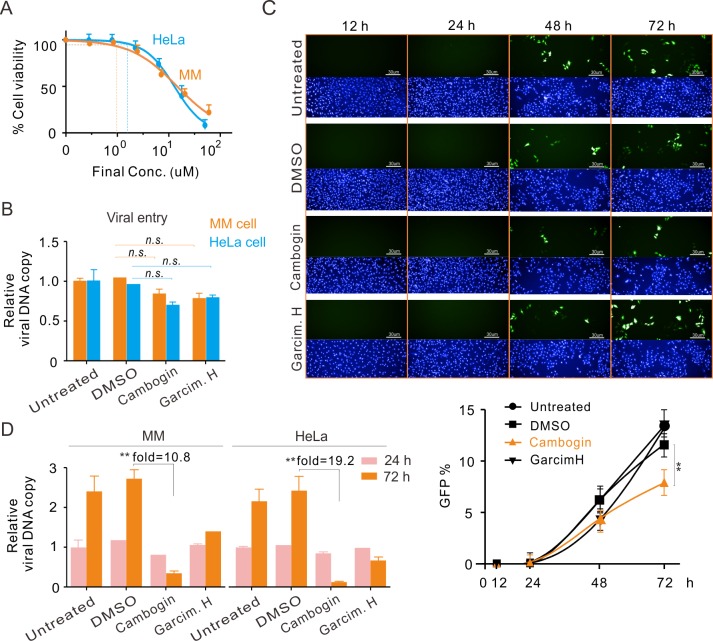
Cambogin inhibits KSHV de no infection in vitro.(A) The cell viability of HeLa and MM cell lines with different dosage of Cambogin treatment for 48 h. The concentration of Cambogin-induced 10% cell death (CC10) was indicated. (B) Cambogin does not impair viral entry. Equal amount of HeLa or MM cells incubated with GFP-tagged KSHV virions (MOI = 2) in the presence or absence of 100 nM Cambogin and Garcimultiflorone H (DMSO as a control), were subjected to viral entry analysis by quantitative PCR. Asterisk indicates p<0.05. n.s., no significant. (C) Cambogin inhibits KSHV de no infection. Equal amounts of MM cells with KSHV infection and compounds treatment as described in panel B for 12, 24, 48, and 72 h, were subjected to immunofluorescence analysis of GFP (green) and nuclei staining by DAPI (blue) to detect the infection efficiency of KSHV. The relative percentages were quantified by flow cytometry analysis and shown at the bottom panels. Asterisk indicates p<0.05. Similar experiments duplicated in HeLa cells see supplemental S2 Fig. (D) Cambogin reduces viral episome DNA copy during KSHV primary infection. HeLa and MM cells with KSHV infection and compounds treatment for 24 and 72 h from panel C, were subjected to quantitative PCR analysis for relative KSHV episome DNA copy number. **p < 0.01.